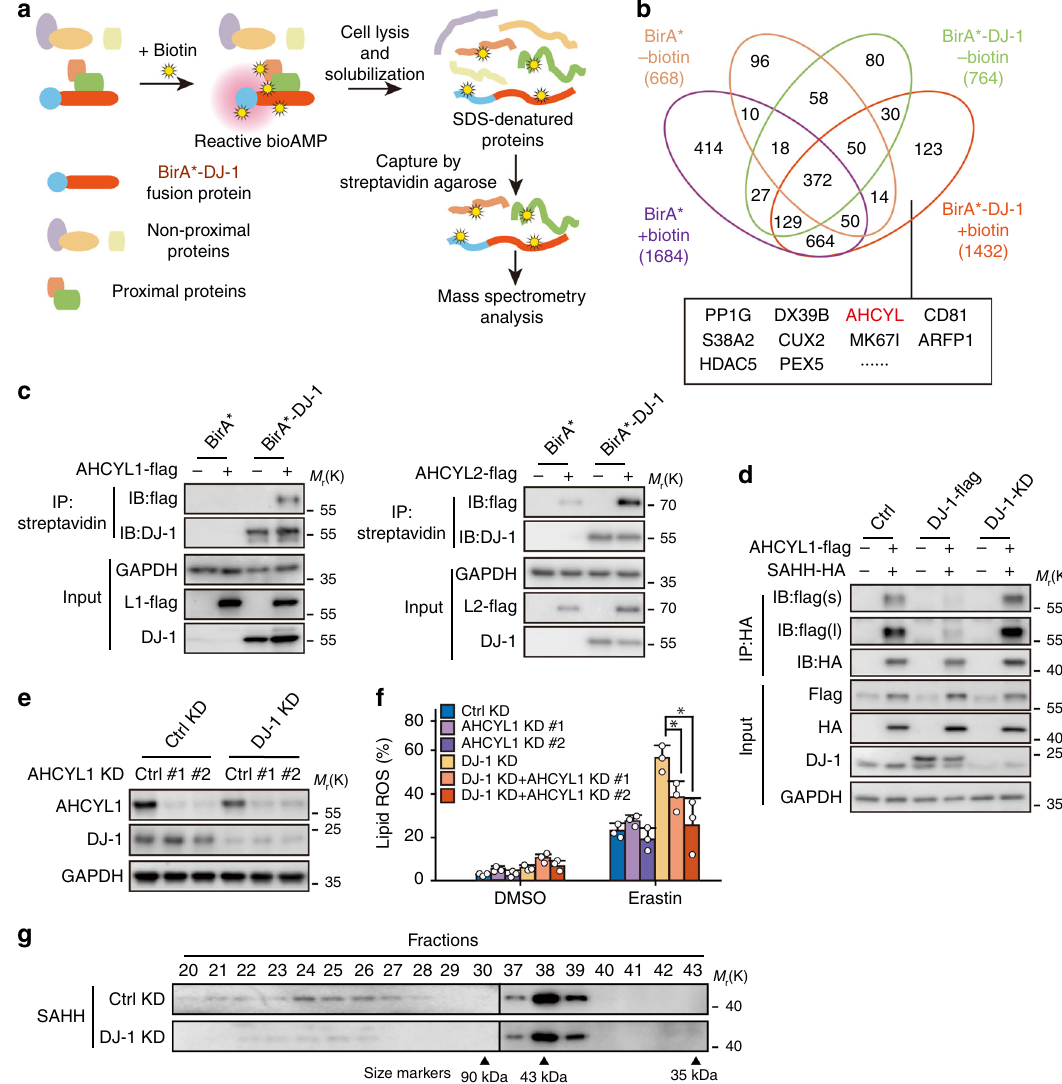
Fig. 6 DJ-1 depletion impairs SAHH tetrameric structure via enhancing the SAHH/AHCYL1 interaction. a The scheme of BioID assay for identifying the interaction proteins of DJ-1. b The results of BioID assay. The numbers indicate the proteins identi fi ed from each group by mass spectrometry, and the top ten proteins speci fi cally identi fi ed in biotin-treated DJ-1-BirA* samples were listed. c The interaction between AHCYL1 (the left view) or AHCYL2 (the right view), and DJ-1 in BirA* system was analyzed. HEK293T cells were transfected with indicated plasmids and treated with DMSO or 50 μ M biotin for 24 h before harvested. Input and samples of IP-streptavidin were separated on SDS – PAGE gels and subjected to immunoblotting with anti-Flag and anti-DJ-1 antibodies. Independent experiments are repeated three times and representative data are shown. d The interaction between AHCYL1 and SAHH under different DJ-1 level was analyzed. Indicated HEK293T cells stably expressing AHCYL1 and SAHH were harvested for immunoprecipitation and subjected to immunoblotting with anti-Flag and anti-HA antibodies (#1 sequence of DJ-1 KD was used here). ‘ s ’ represents short exposure; ‘ l ’ represents long exposure. Independent experiments are repeated three times and representative data are shown. e Western blot analysis of DJ-1 and AHCYL1 expression in indicated H1299 cells (#1 sequence of DJ-1 KD was used here). Independent experiments are repeated three times and representative data are shown. f Indicated DJ-1 KD (#1 sequence) and AHCYL1 KD H1299 cells were treated with erastin (2 μ M) for 12 h, and lipid ROS production was assayed. Data shown represent mean ± SD from three independent experiments. Comparisons were made using the two-tailed, unpaired Student ’ s t -test; * p < 0.05. g Western blot analysis of the fractions from size-exclusion chromatography experiment, showing less tetrameric SAHH complex (fraction 23 – 28) in DJ-1 KD H1299 cells (#1 sequence of DJ-1 KD was used here). Independent experiments are repeated three times and representative data are